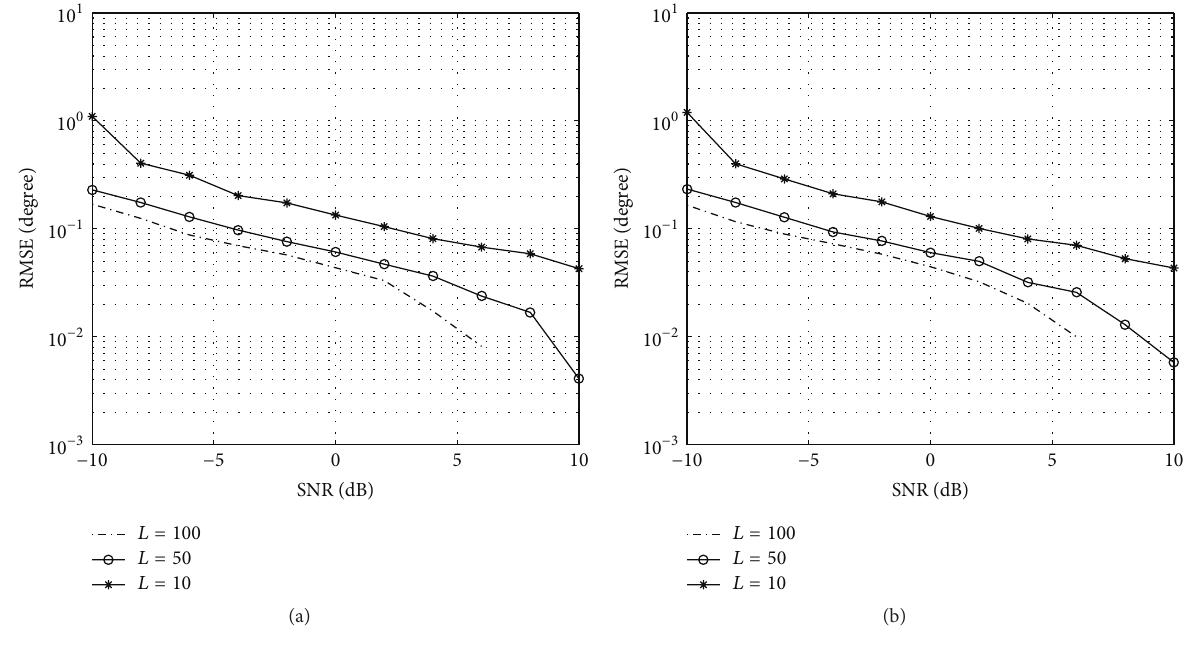
Figure 4: The performance for DOD and DOA estimation with different 𝐿 . (a) DOD and (b) DOA.